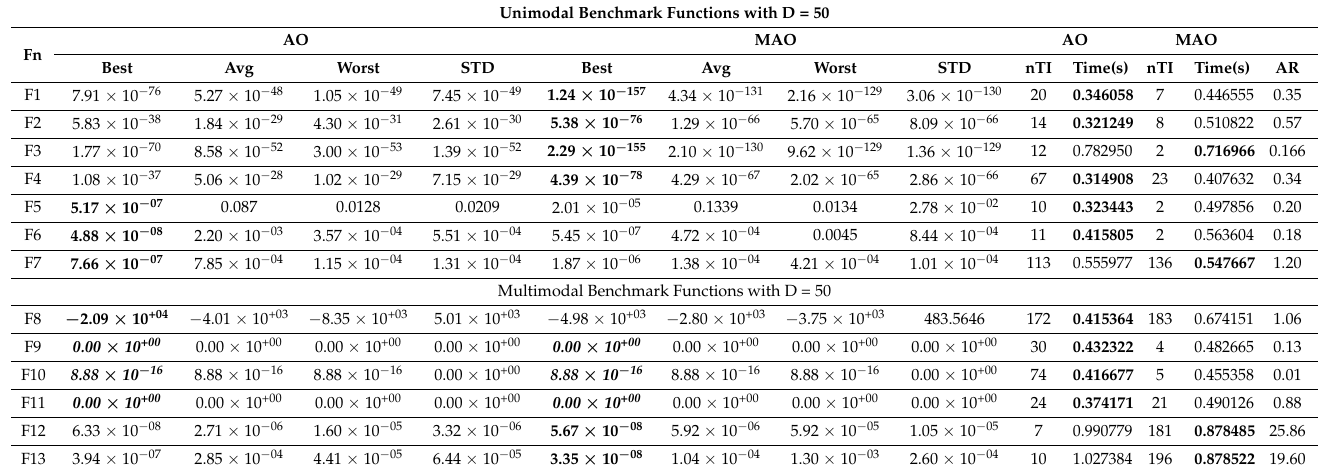
Table 6. Results obtained for unimodal and multimodal functions with D = 50.